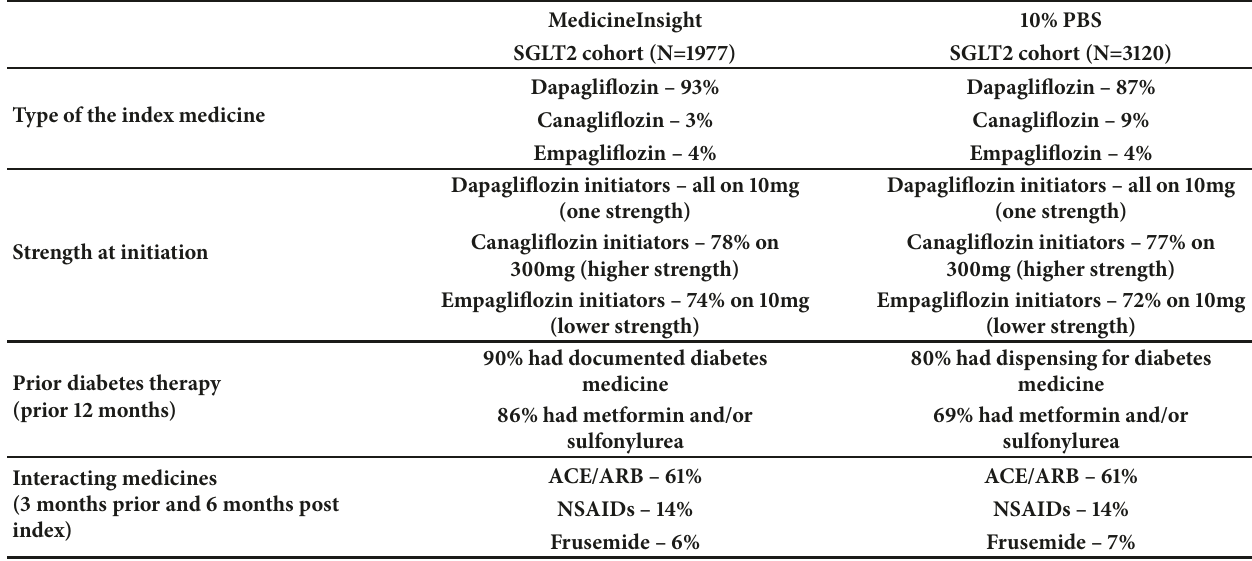
Table 2: Other indicators.